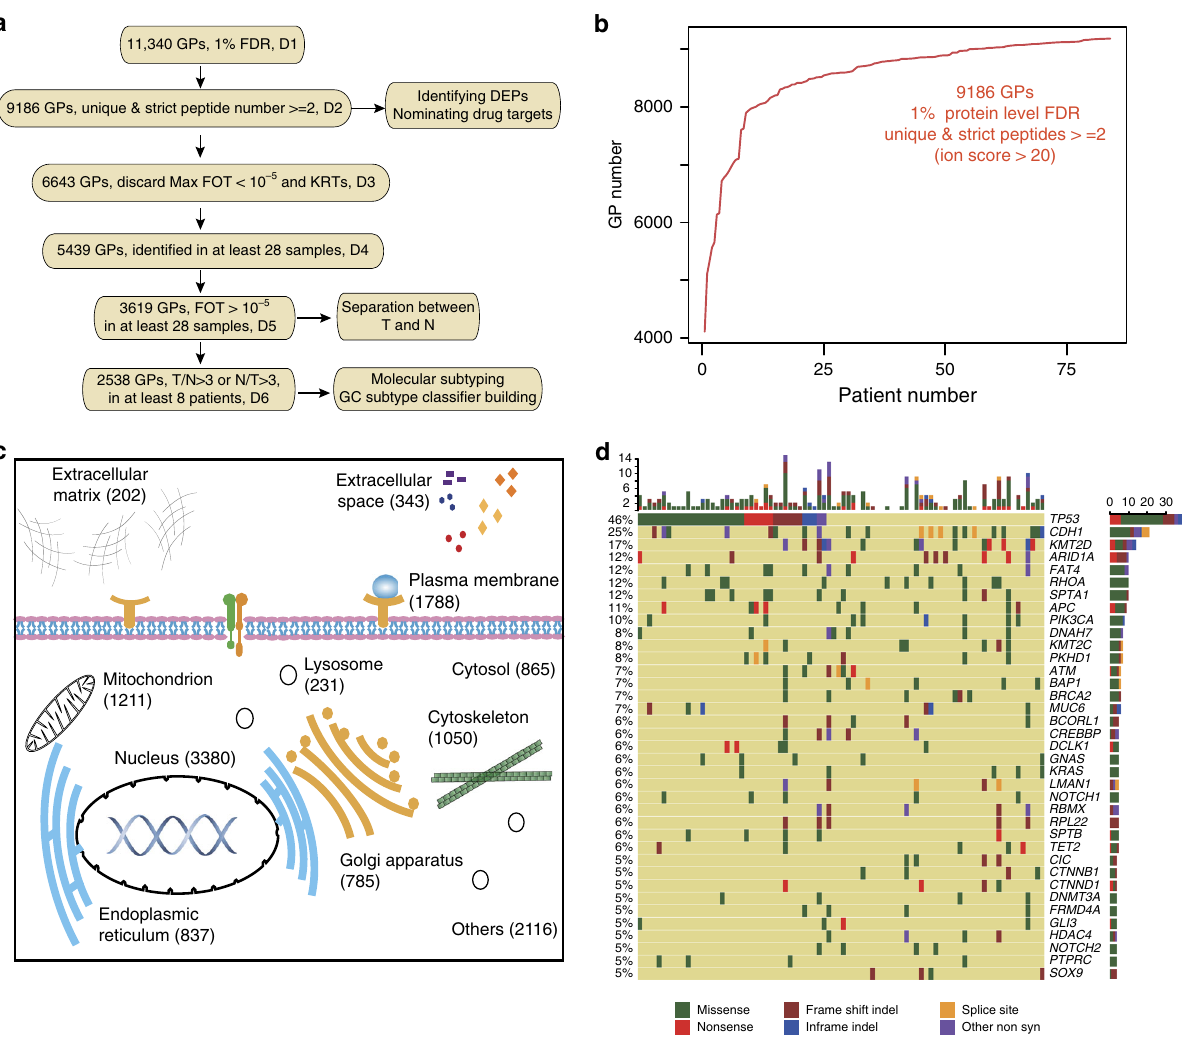
Fig. 1 A summary of proteomic and genomic analysis of diffuse-type gastric cancer. a Proteomic datasets fi ltered at different levels for various statistical analyses. D1: all gene products (GPs) identi fi ed in 168 samples (84 patients) at 1% protein level FDR; D2: high con fi dence unique proteins identi fi ed with ≥ 2 unique peptides with ion score > 20 and peptide FDR < 1% that were used for identifying differentially expressed proteins (DEPs) between tumors and nearby tissues; D3: GPs in the medium to high abundance range (FOT > 10 − 5 in at least one case), D4: GPs identi fi ed in more than one-sixth of the samples; D5: common GPs in the medium to high abundance range (FOT > 10 -5 ) in D4, D6, differentially expressed proteins. b Cumulative number of proteins identi fi ed as a function of patient numbers. c Subcellular distribution of DGC proteins annotated with Gene Ontology. d Targeted exome sequencing was performed. Genes with non-silent variants in at least 4 patients (5%) were depicted on the OncoPrint. Bars on top and to the right of the graph show the number of non-synonymous mutations in each patient and gene,